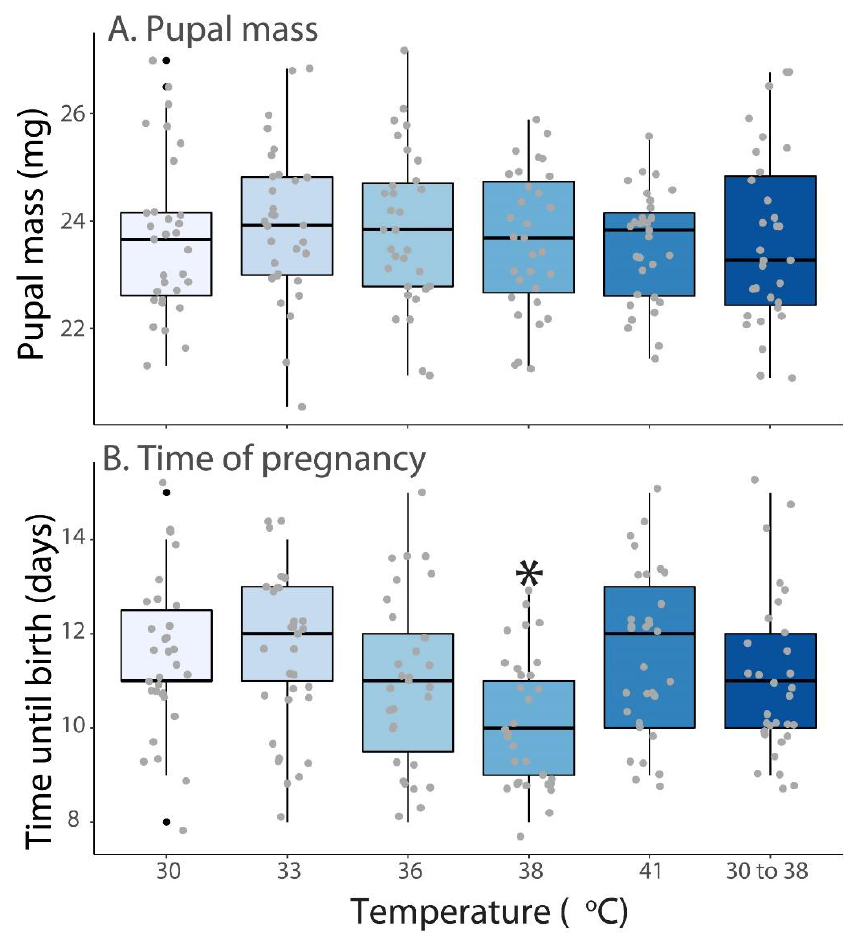
Figure 2. Progeny size and pregnancy duration changes in relation to blood meal temperature. ( A ). Pupal mass and ( B ). time of pregnancy in relation to the composition of blood at multiple temperatures. 30 to 38 ◦ C represents a group of flies provided a cool bloodmeal for two feeding periods and a warm bloodmeal for the other two. Statistical differences were assessed with the use of ANOVA followed by post hoc tests. Different colors represent temperature differences. Gray dots indicate the range of pupal mass and time of pregnancy. Black dots indicate extreme values. Asterisks indicate significant differences.